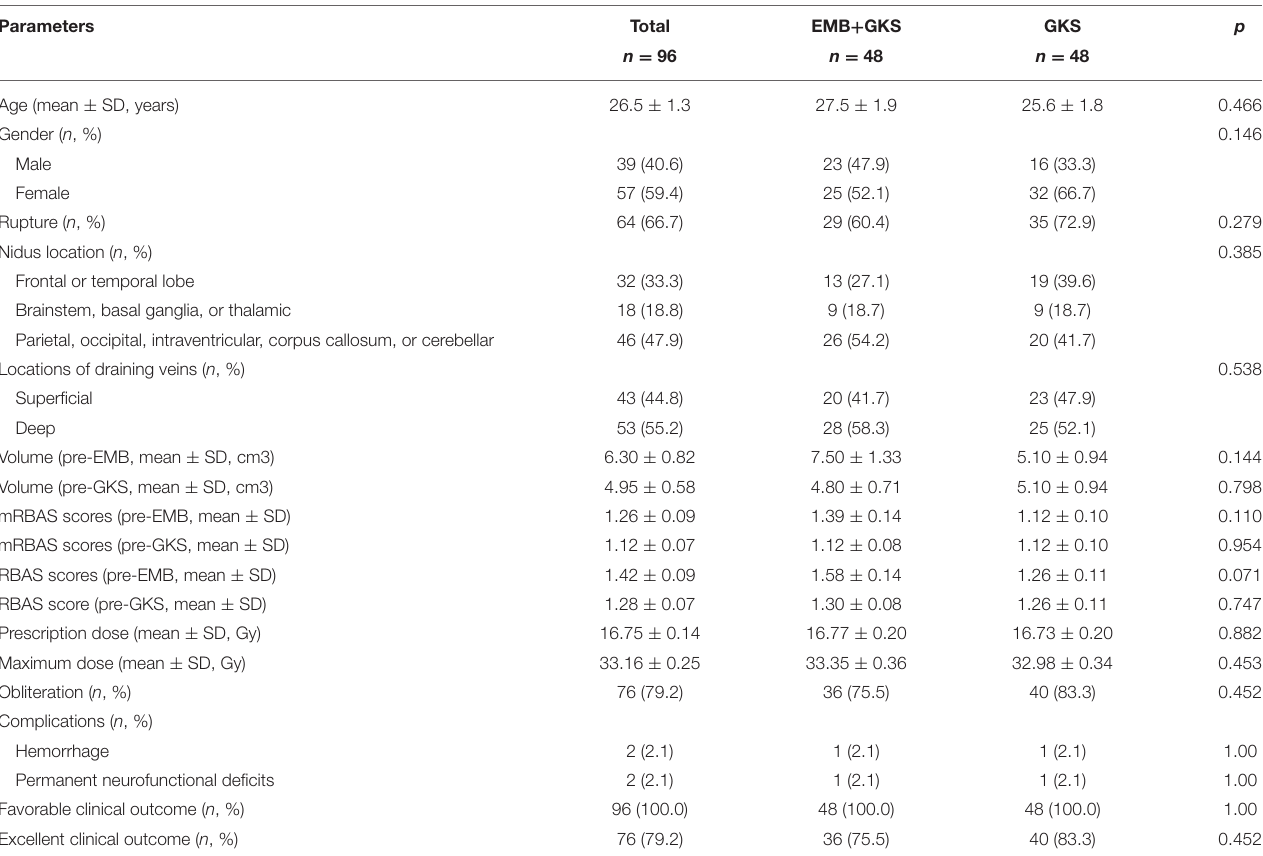
TABLE 1 | Matched patients’ clinical and radiographical